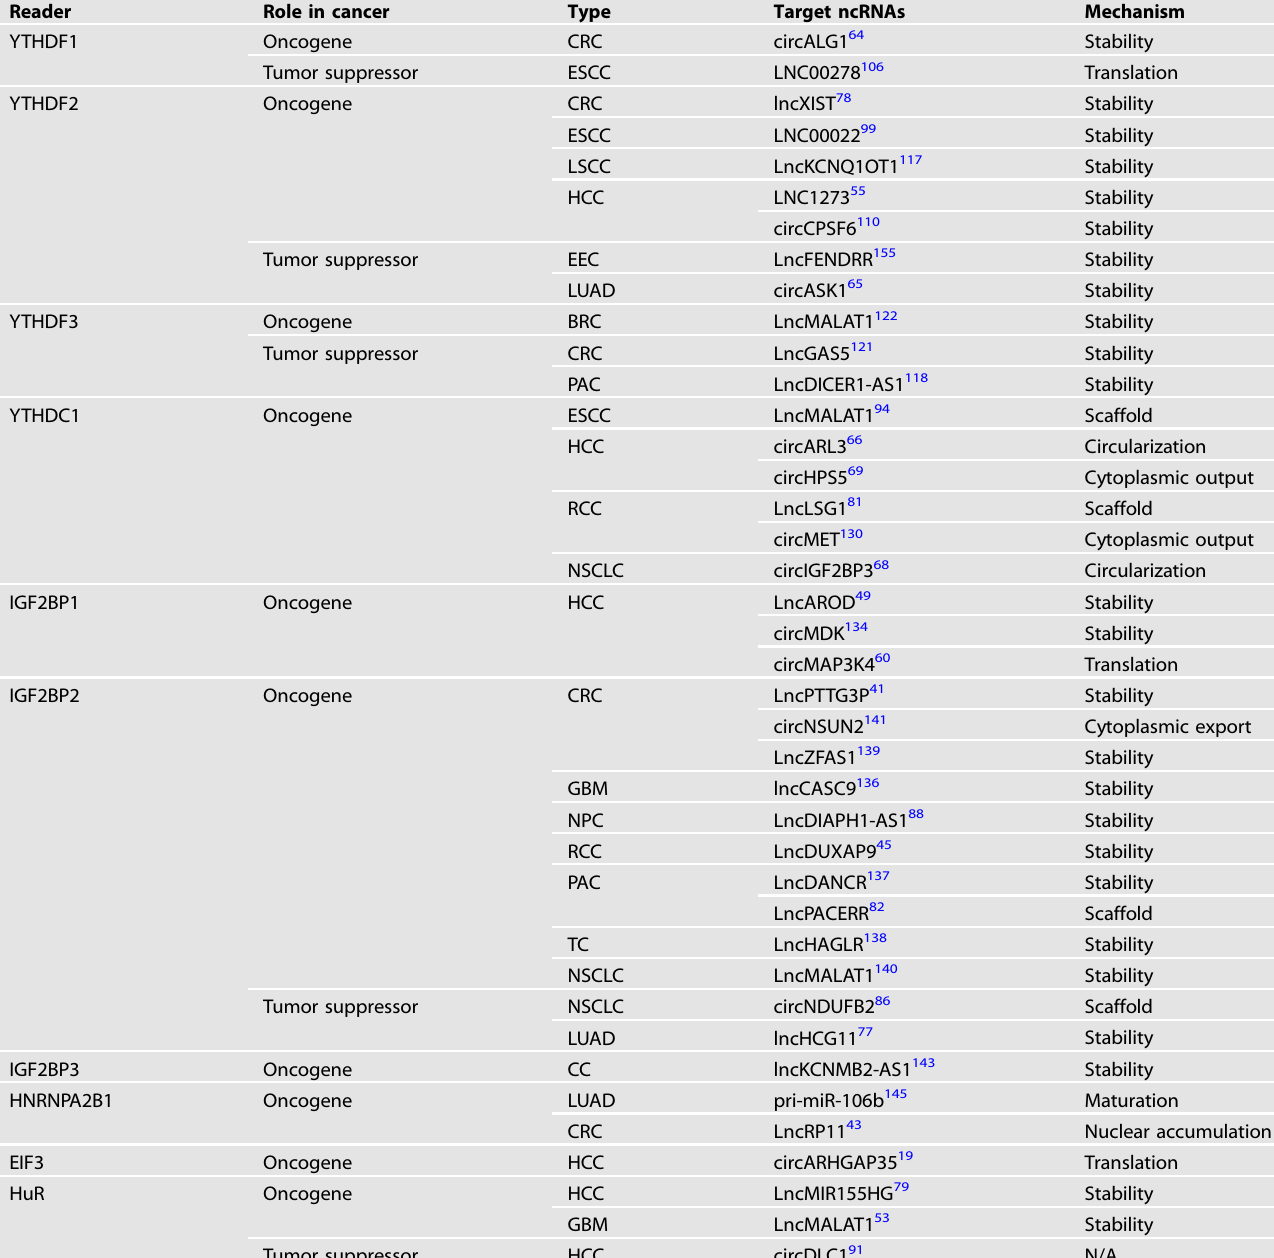
Table 3. Dysregulation of m6A-binding proteins in